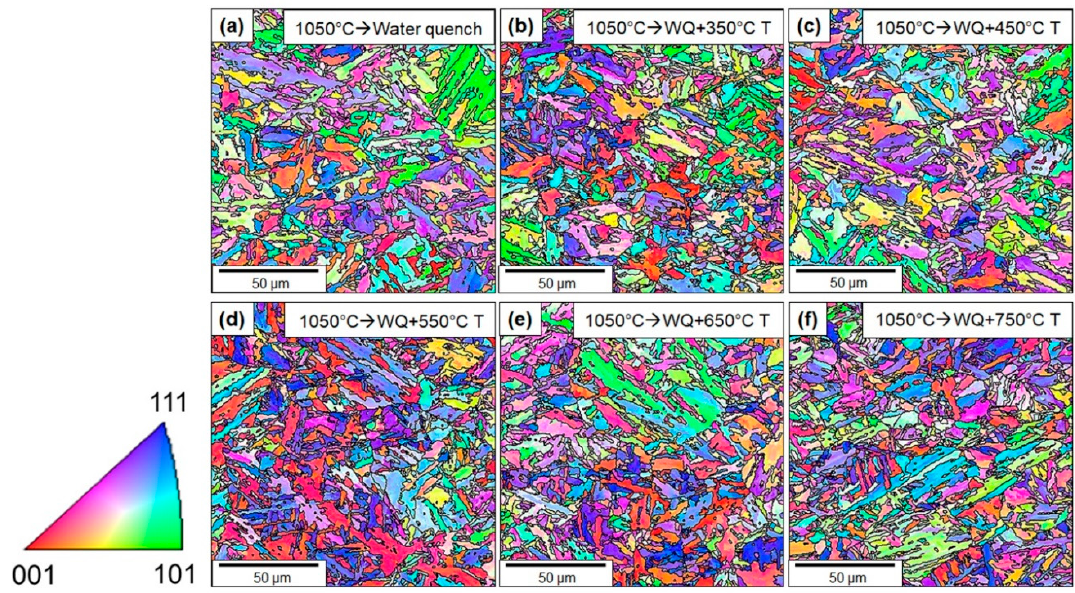
Figure 14. EBSD micrographs of ( a ) austenitized followed by water-quenched and tempered samples with tempering temperature; ( b ) 350 °C; ( c ) 450 °C; ( d ) 550 °C; ( e ) 650 °C; ( f ) 750 °C.